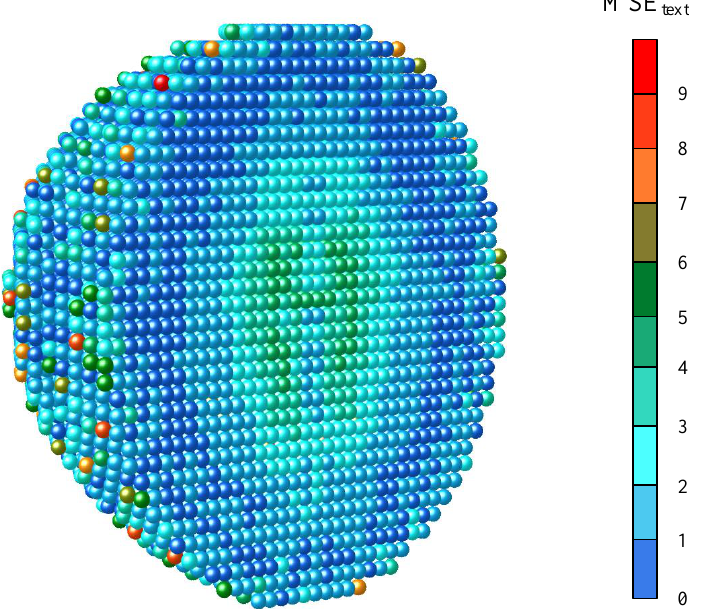
Figure 17. The MAE text of the OAA index prediction model of each reachability